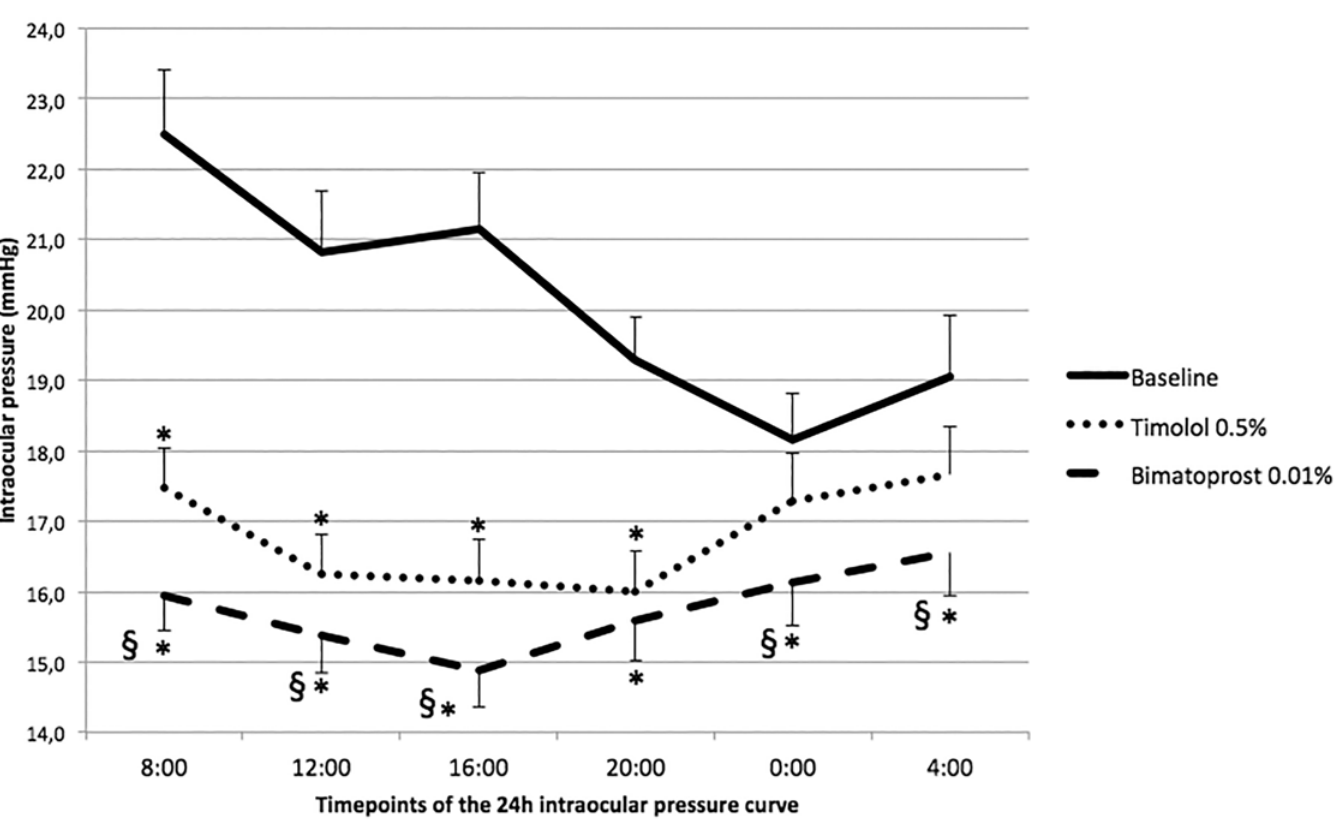
Fig 2. Intraocular pressure at each time point of the daily curve. Error bars represents standard error; * = p < 5% for timepoint comparison versus baseline; § = p < 5% for timepoint comparison between timolol 0.5% bid and bimatoprost 0.01% plus placebo.